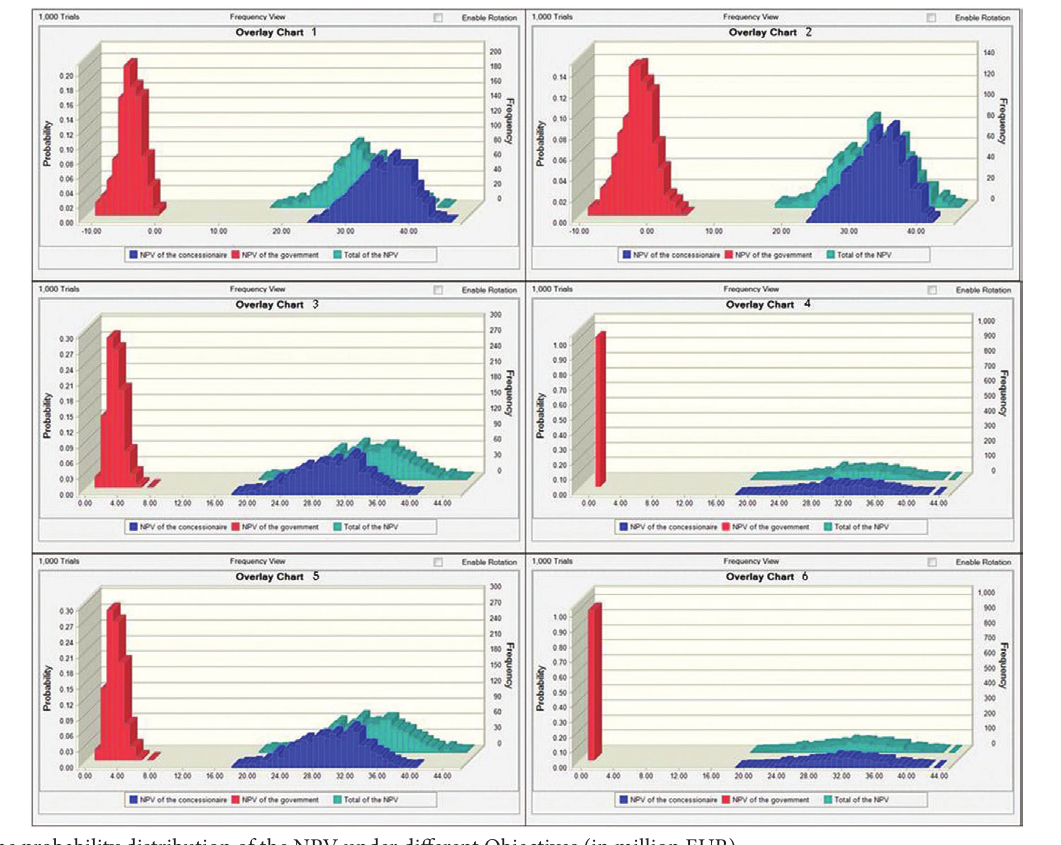
Fig. 2. The probability distribution of the NPV under different Objectives (in million EUR) Table 3. Comparisons of the concessionaire’s NPV under different cases (in million EUR)